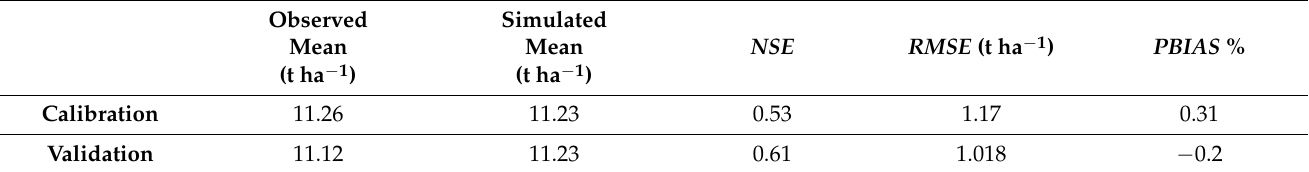
Table 2. Showing Nash–Sutcliff efficiency ( NSE ), root mean square error ( RMSE ) and per cent bias ( PBIAS ) for calibration and validation